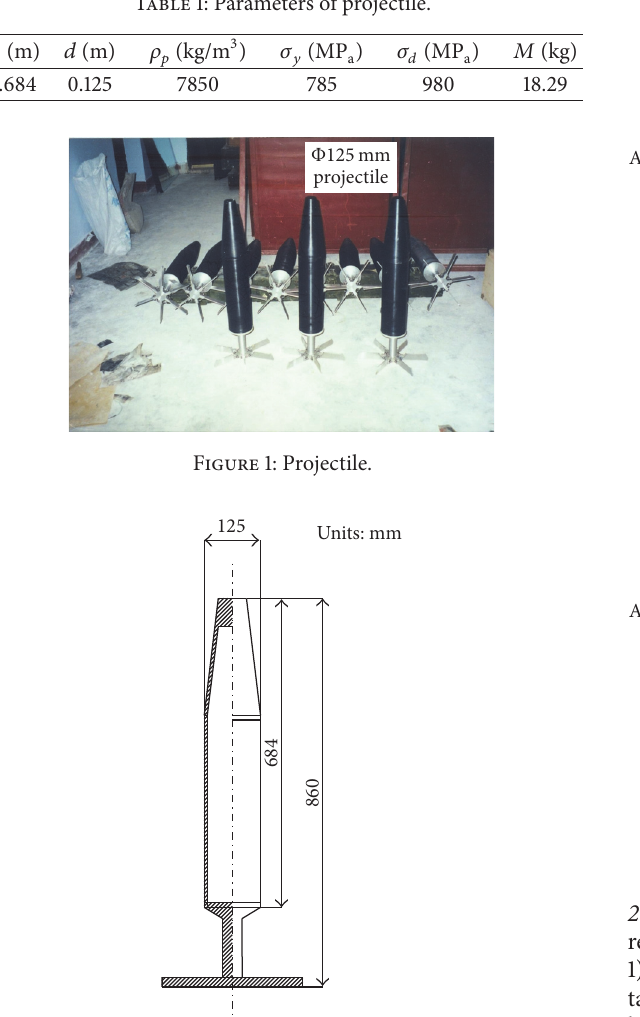
Figure 2: Structure diagram of projectile.